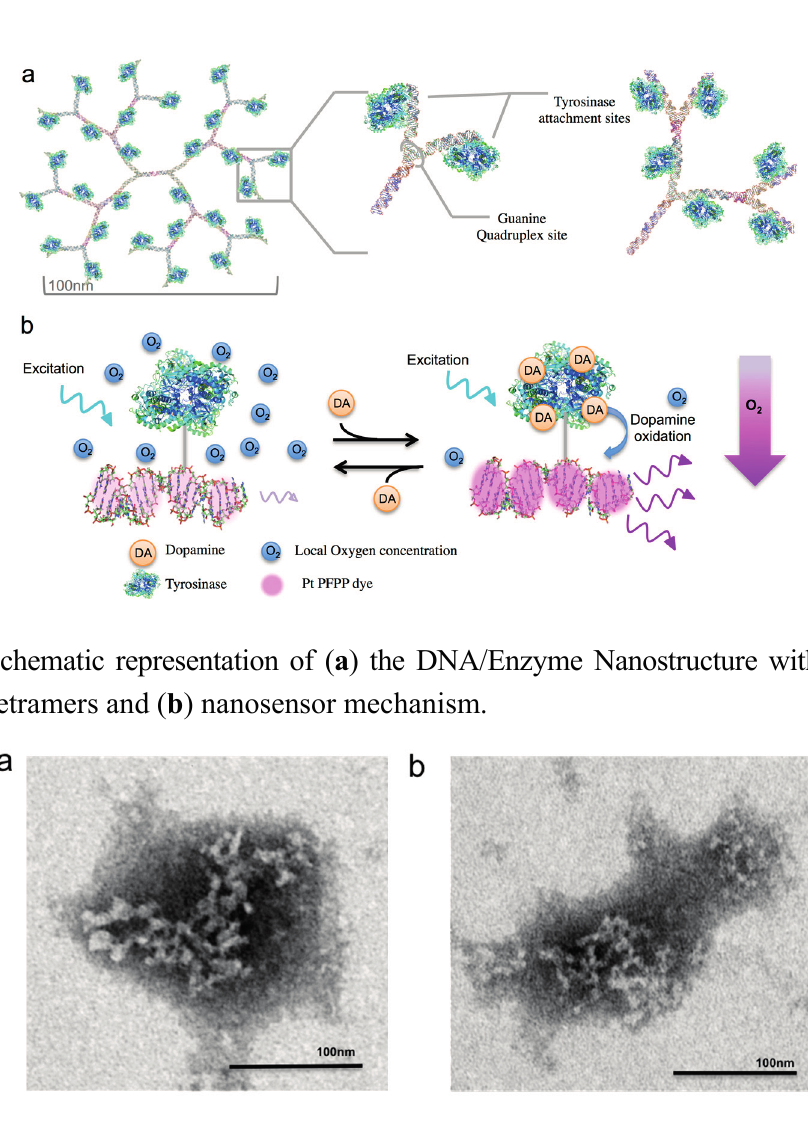
Figure 2. Negative stain transmission electron microscopy image of two QuID nanosensors ( a ) with visible branching and elongated shape, and ( b ) a single QuID nanosensor.